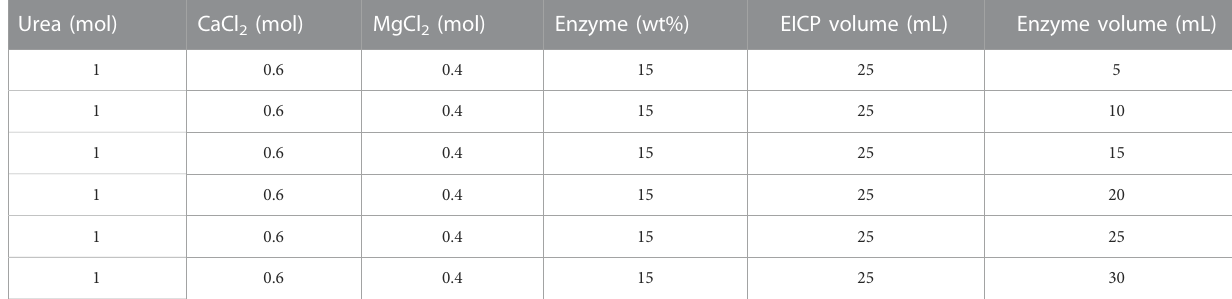
TABLE 3 Chemical formulations used for the effect of the enzyme volume